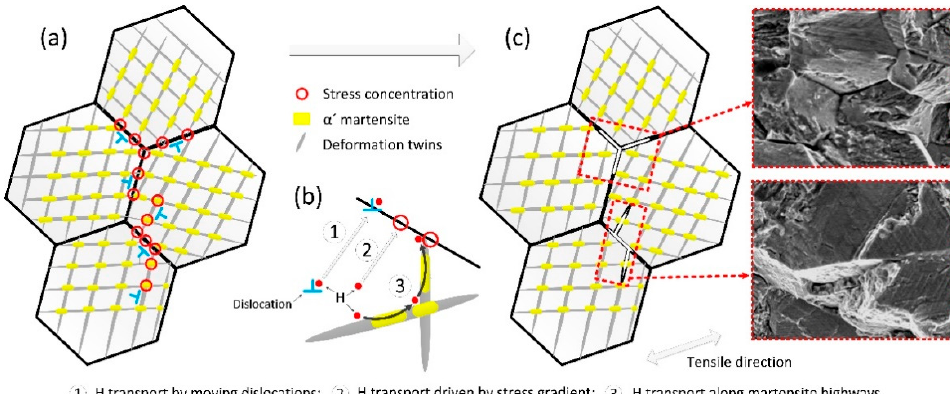
Figure 12. Schematics for the intergranular (IG) cracking and twin boundary separations. ( a ) Stress concentrations arising at the grain or twin boundaries and their intersections; ( b ) Hydrogen transport ways to these boundaries and intersections: ① transported by moving dislocations, ② stress-assisted hydrogen diffusion, ③ transported through α′ “highways”; ( c ) IG fracture initiates at the intersections.